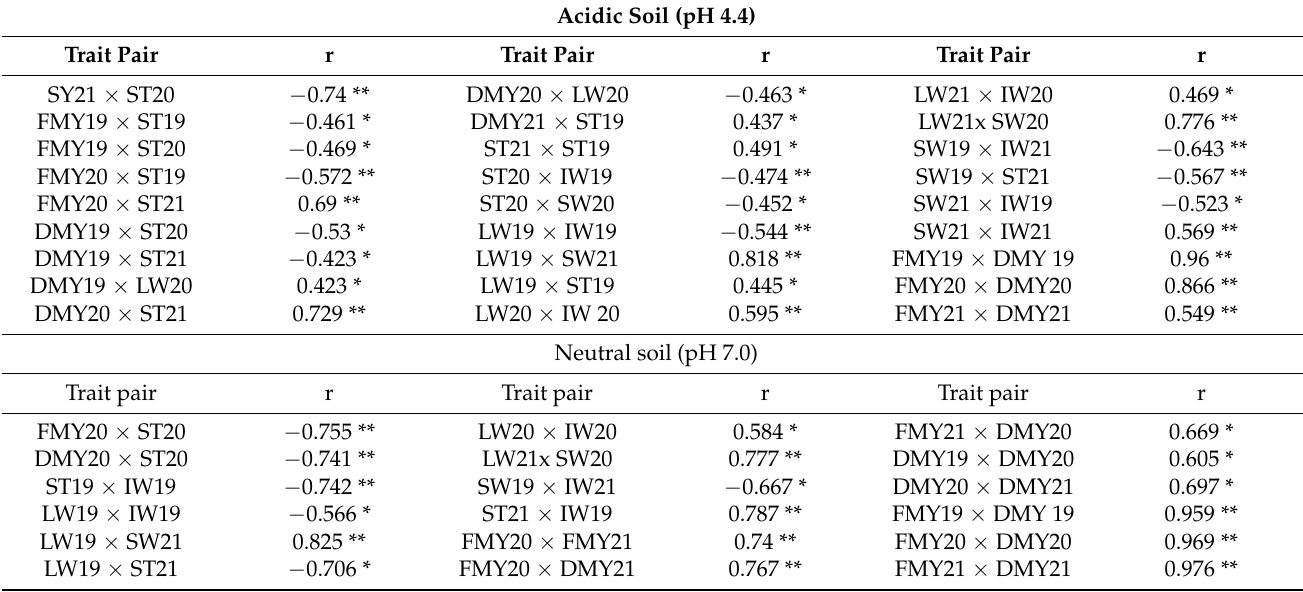
Table 7. The correlation coefficients between productivity traits and stem thickness, stem weight, leaf weight, and inflorescence weight of alfalfa populations from 2019 to 2021. Acidic Soil (pH